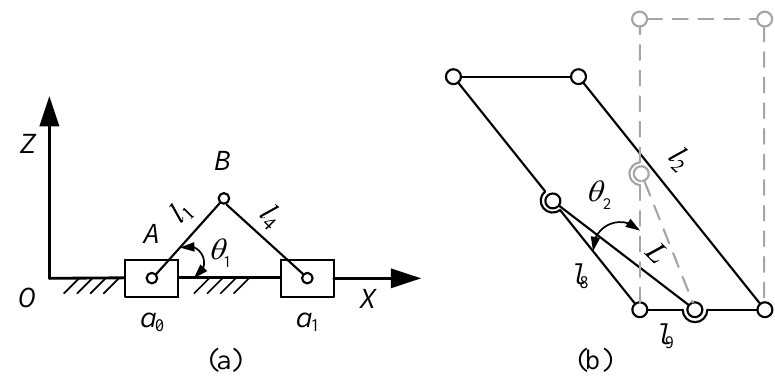
Figure 6. Parallel mechanism model ( a ) and parallelogram mechanism model ( b ).